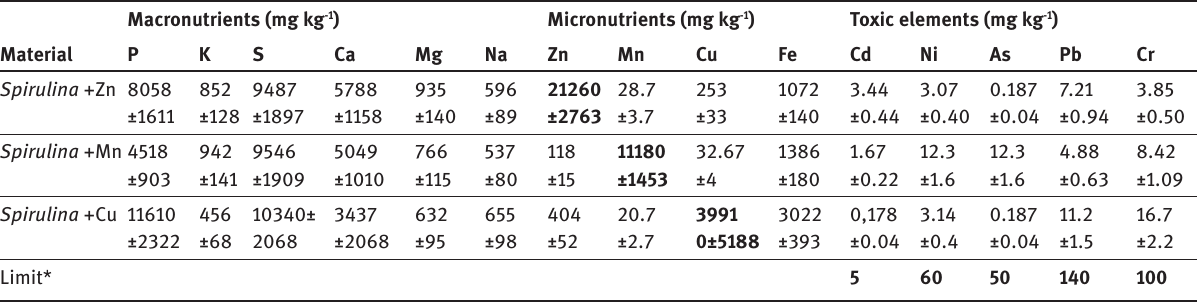
* Act of fertilizer and fertilization, 18 June 2008, approved by Polish Ministry of Agriculture and Rural Development.